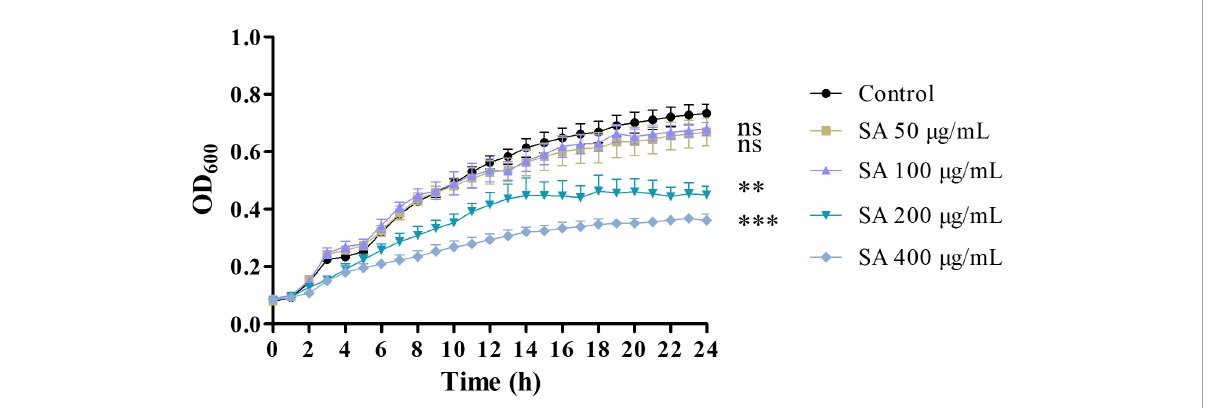
FIGURE1 Effect of Sennoside A (SA) on the growth of PAO1. All data were expressed as mean ± SD values with three independent experiments performed in triplicate. ns p > 0.05; ∗∗ p < 0.01; ∗∗∗ p <